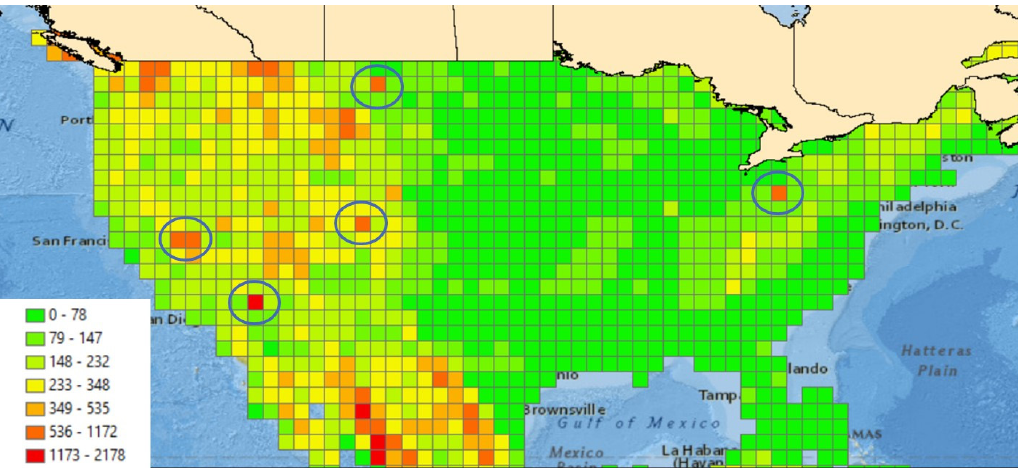
Figure 9. Map of maximum percent slope values found in Shuttle Radar Topography Mission (SRTM) DEM of the USA. Suspiciously high values are circled.